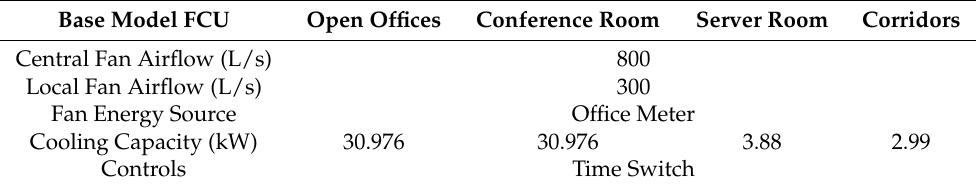
Table 9. Design variables for FCU with Variable Speed Drive (VSD).